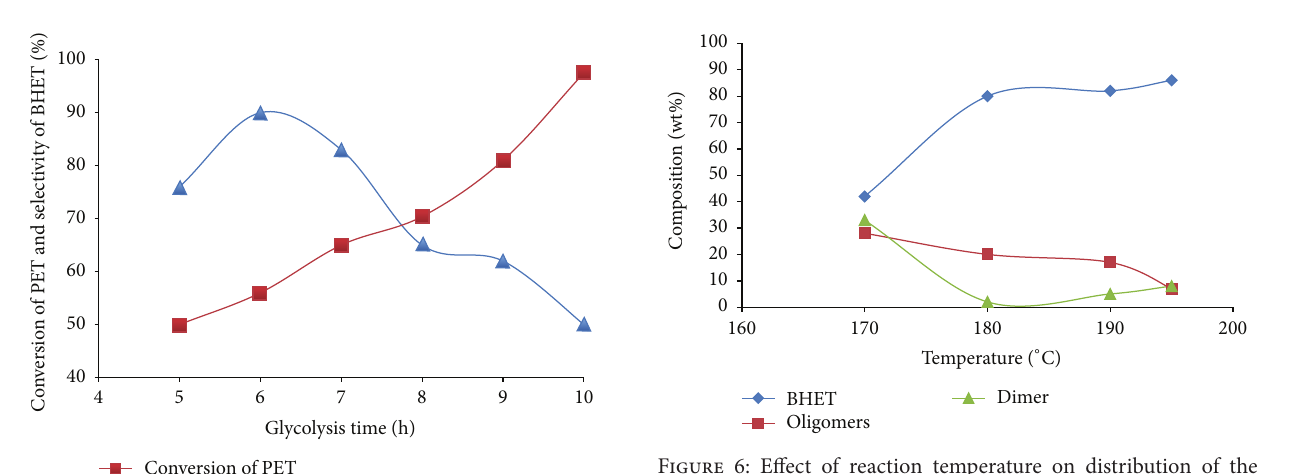
percentage of the oligomers first decreased and then it is going to be enhanced like the trend which was mentioned before.